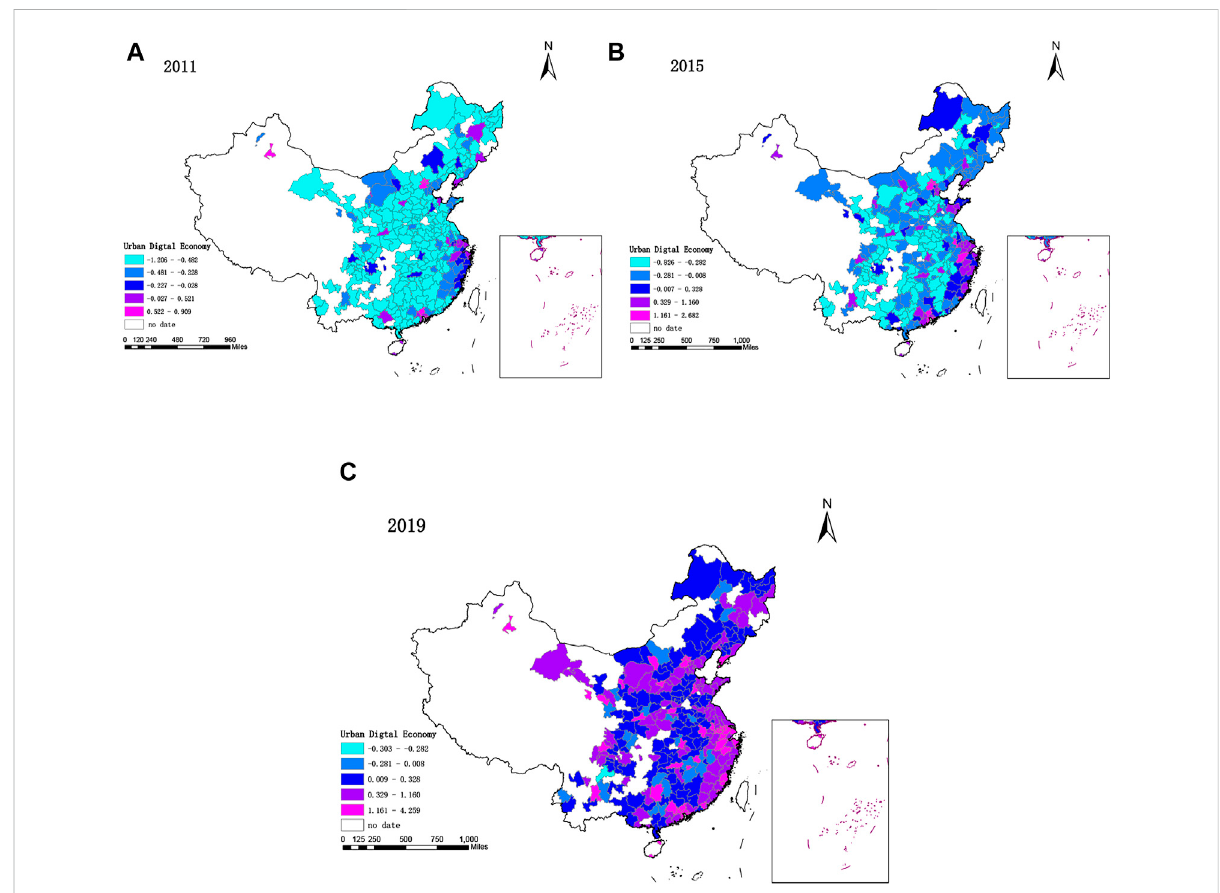
FIGURE 3 Spatial and temporal evolution of digital economy in Chinese cities in 2011 (A) , 2015 (B) , and 2019 is shown in (C)